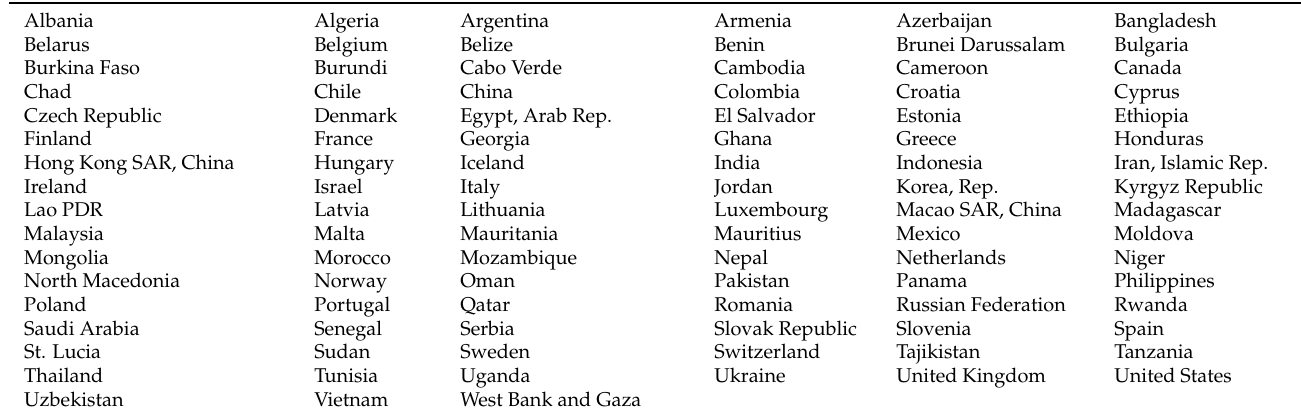
Table A1. List of